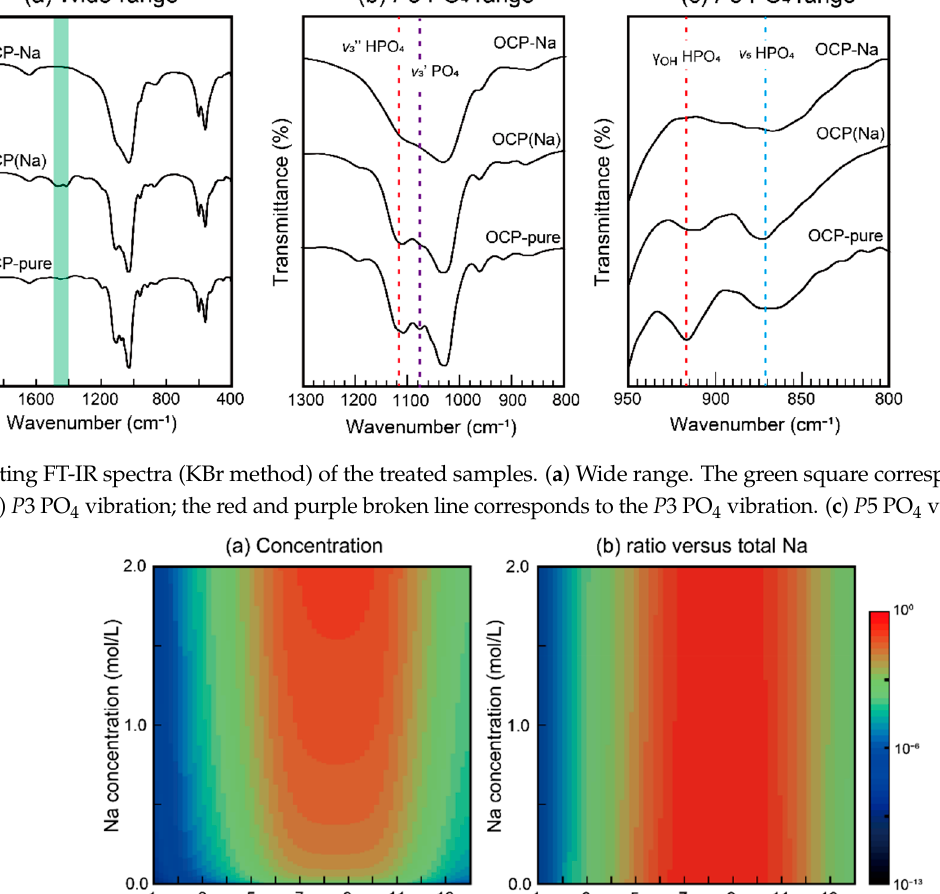
Figure 2. Transmitting FT-IR spectra (KBr method) of the treated samples. ( a ) Wide range. The green square corresponds to CO 3 adsorption. ( b ) P 3 PO 4 vibration; the red and purple broken line corresponds to the P 3 PO 4 vibration. ( c ) P 5 PO 4 vibration.